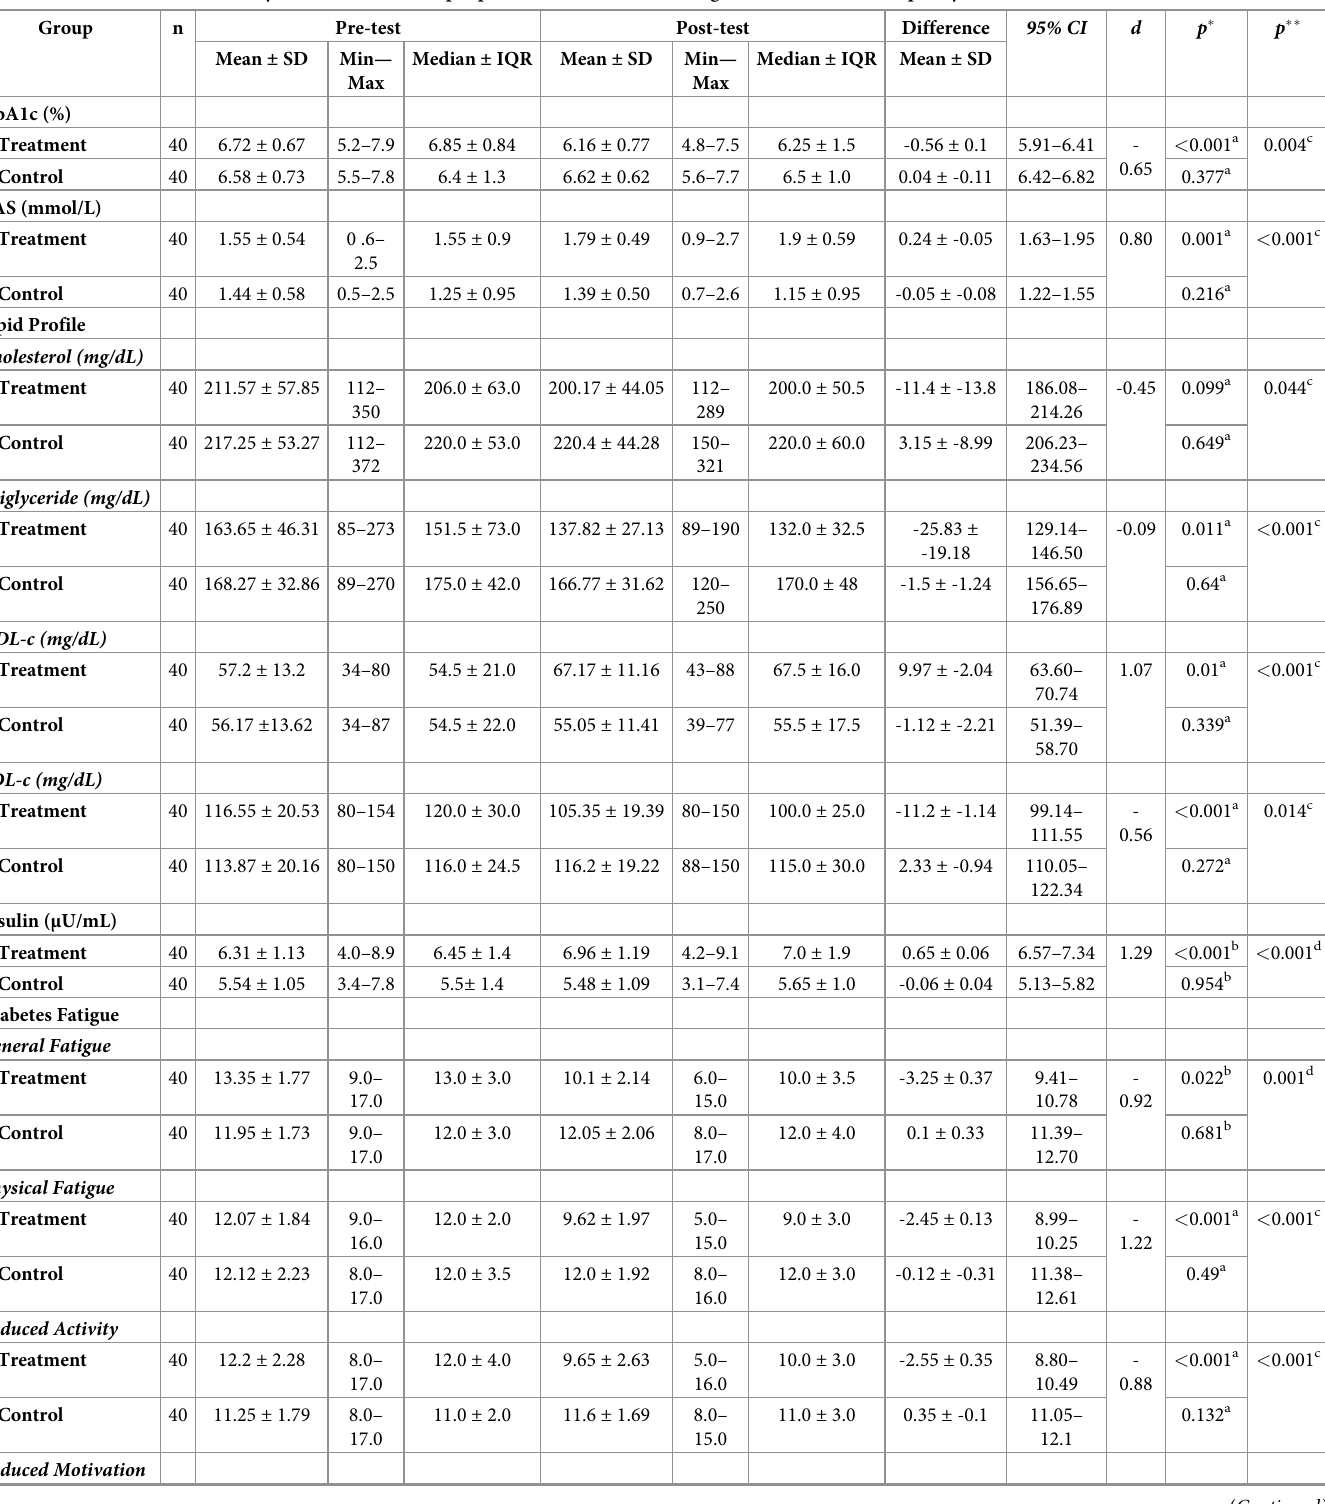
Table 3. The distribution and analysis of HbA1c, TAS, lipid profile, insulin, diabetes fatigue, and health related quality of life.